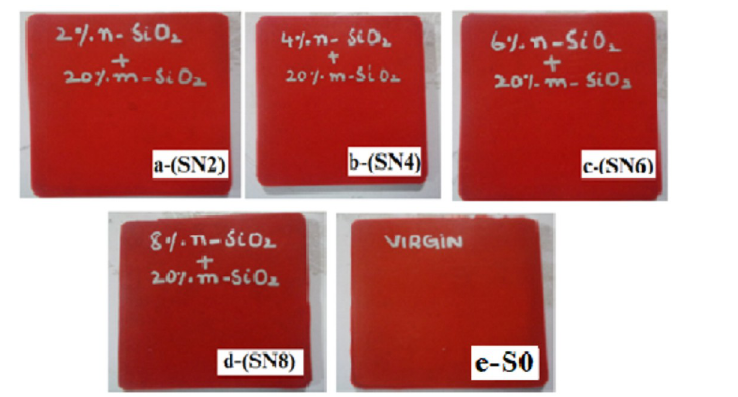
Fig 1. Original Samples, a- SN2, b-SN4, c-SN6, d-SN8 and e-S0.